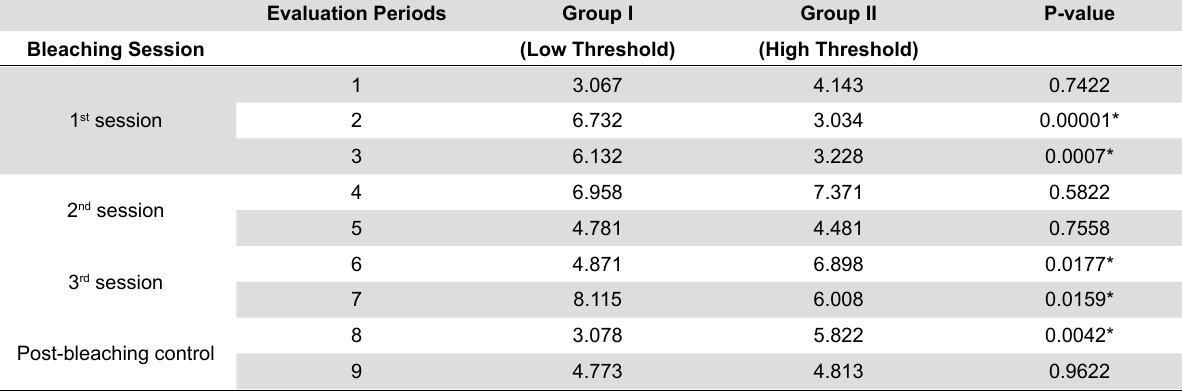
Figure 7- Study groups and experimental and placebo products composition Table 2- P-values obtained after skin cold sensation threshold evaluation in different